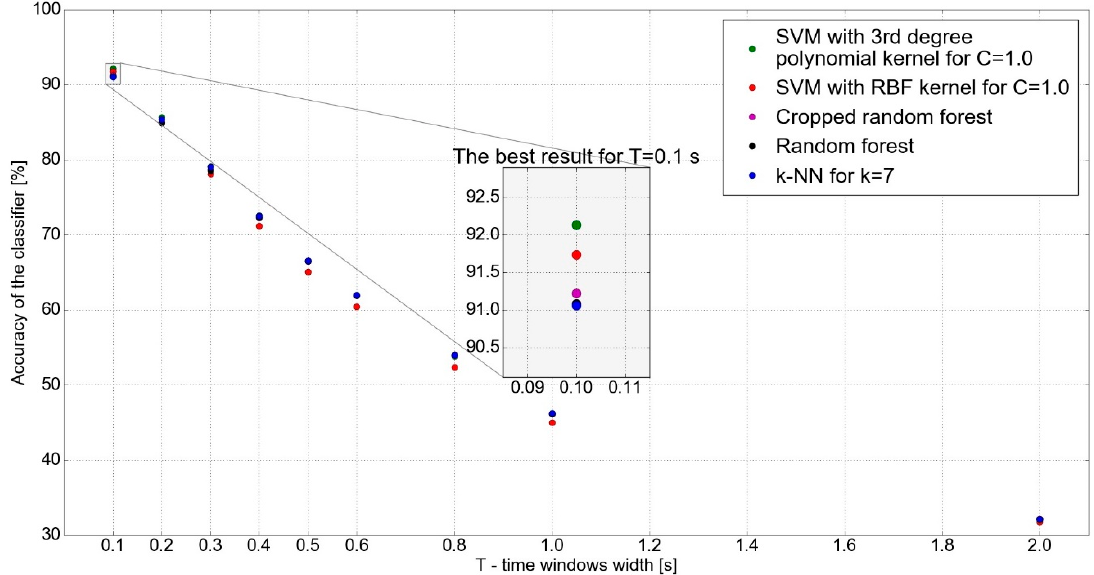
Figure 4. Accuracy of the classifiers for different widths of time window T for the test data.